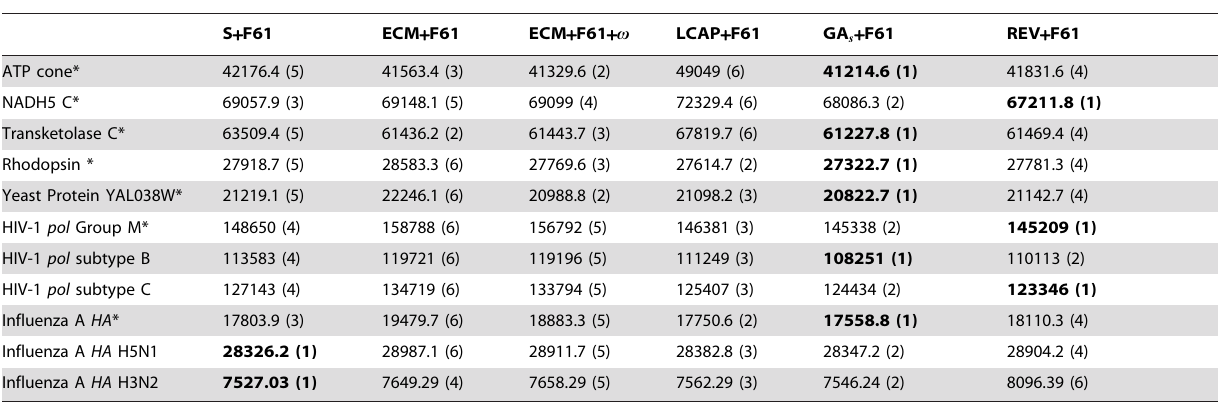
Table 4. Comparison of empirical model fits using